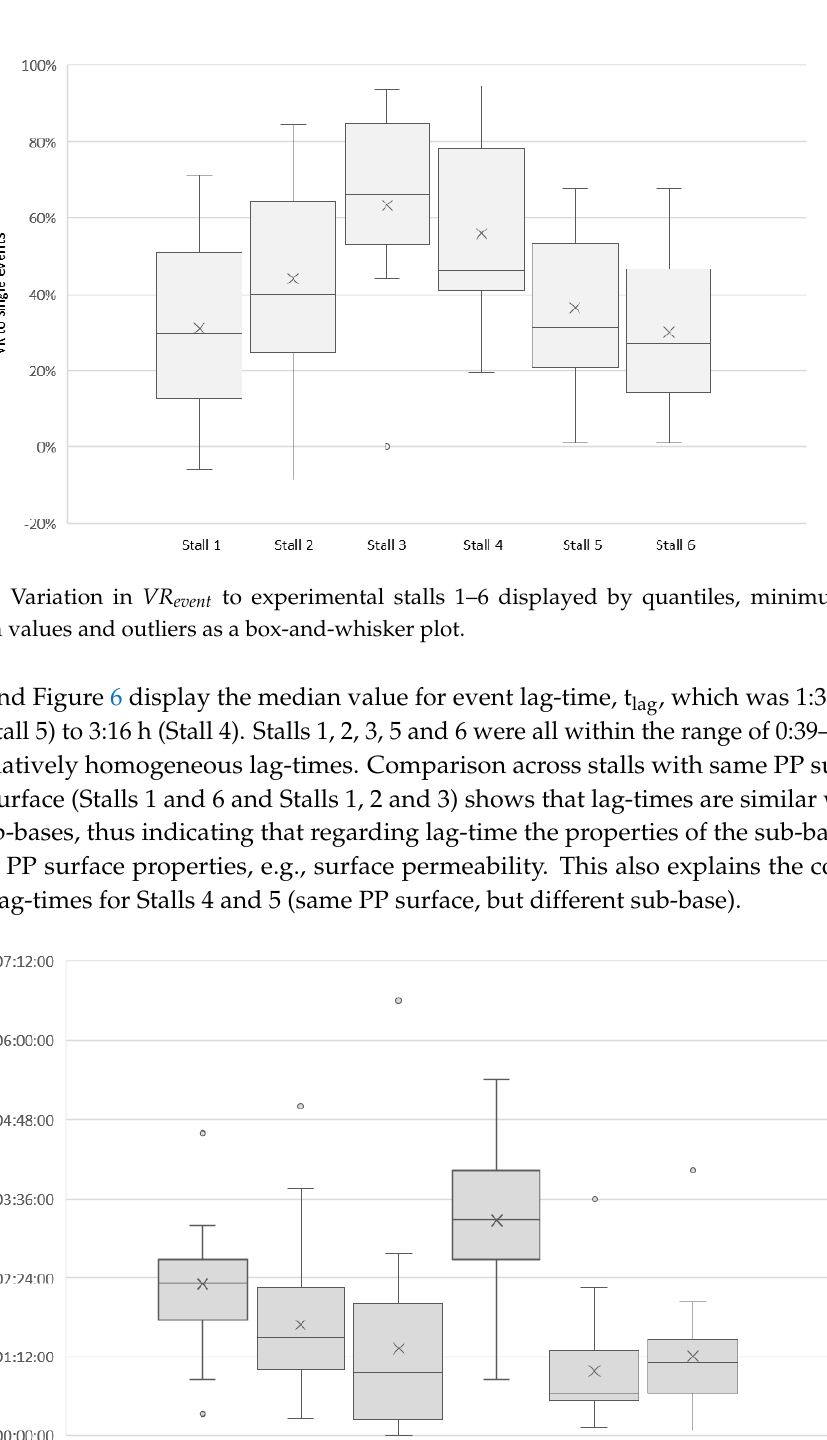
Figure 6. Variation in t lag to experimental stalls 1–6 displayed by quantiles, minimum and maximum values and outliers as a box-and-whisker plot.